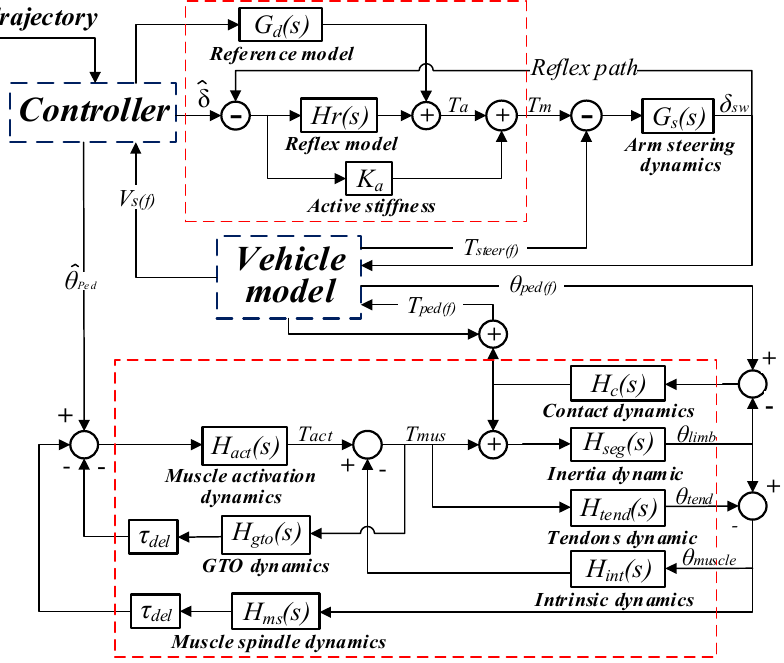
Figure 1. Human–vehicle shared control (HVSC) dynamics model.